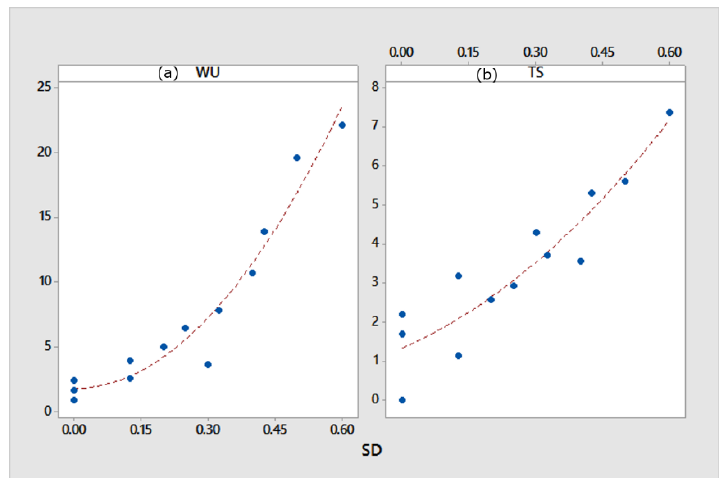
Figure 5. Scatter plot of ( a ) water uptake (WU%) and ( b ) thickness swelling (TS%) for samples as function of SD content. Table 4. Effects of component contents on the interaction of rPET WPC with water. Interaction with